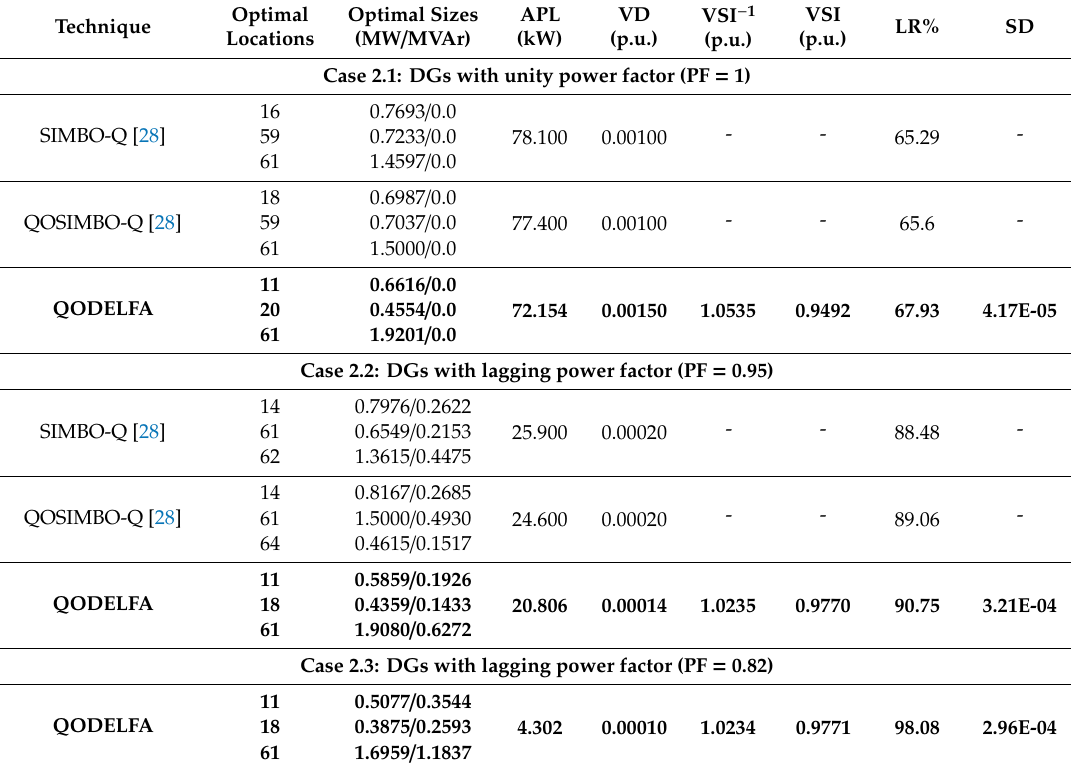
Table 7. Results for the IEEE 69-bus RDS with simultaneous minimization of OF 1 and OF 2 .